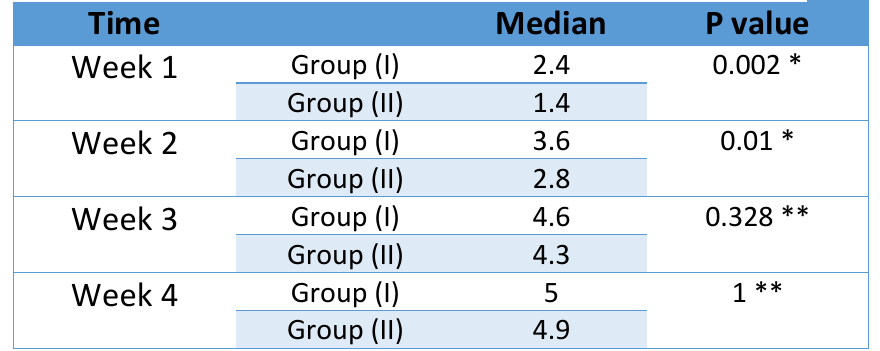
Table 3. Median score for healing